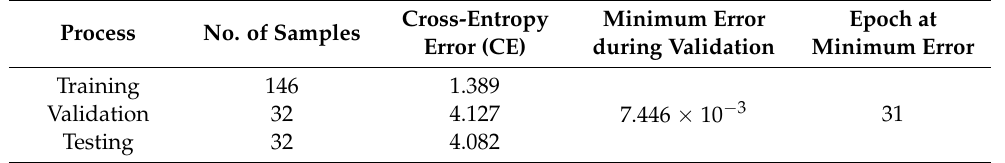
Table 4. Cross-entropy performance of classified